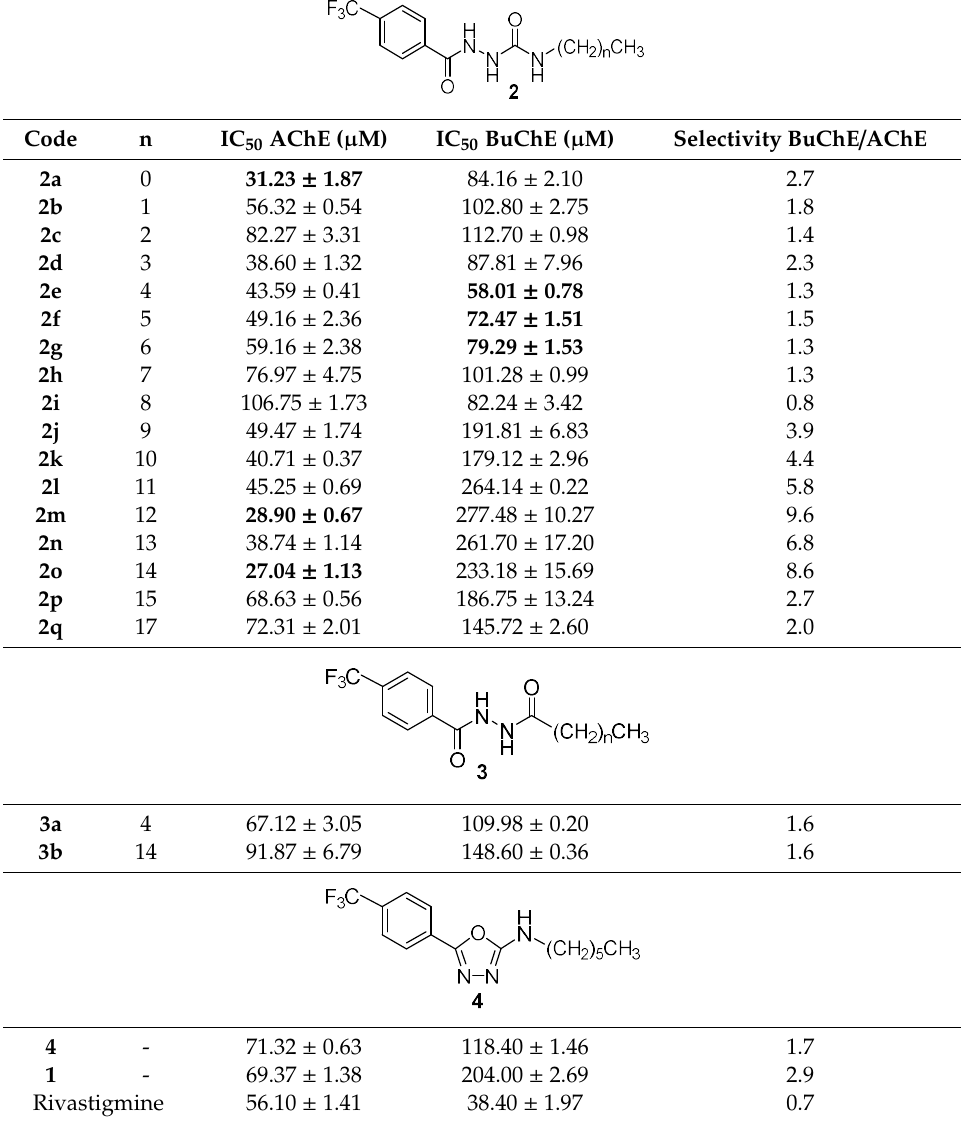
AChE and BuChE inhibition are expressed as the mean ± SD ( n = three independent experiments). The three lowest IC 50 values for each enzyme are given in